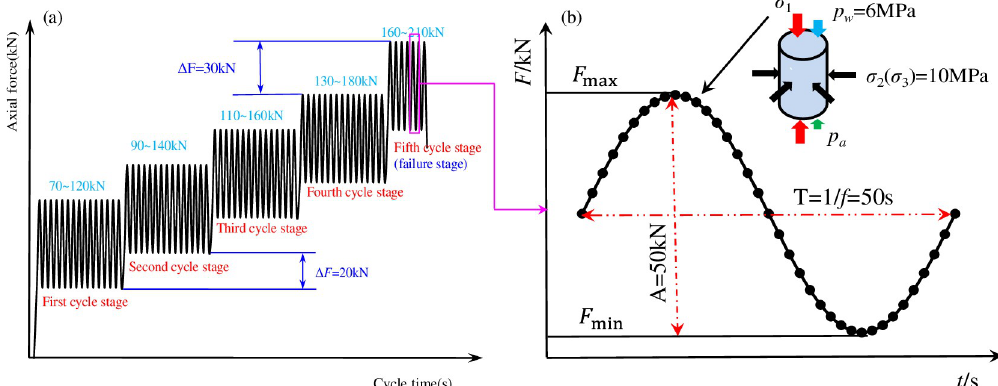
Fig 5. Schematic diagram of tiered cyclic loading and Sketch of sine wave loading (water pressure 6MPa).